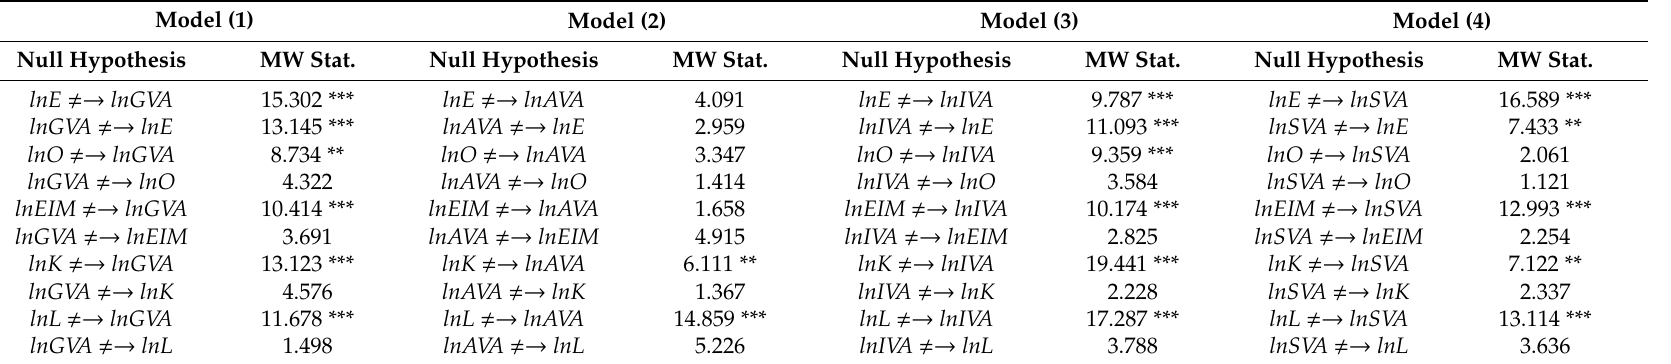
Table 7. The Hacker-Hatemi-J bootstrapped causality test